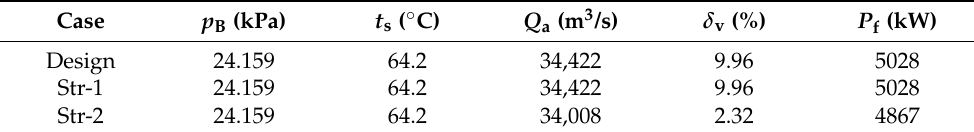
Table 3. Comparison of main parameters for Design, Str-1, and Str-2 cases under windless condition.